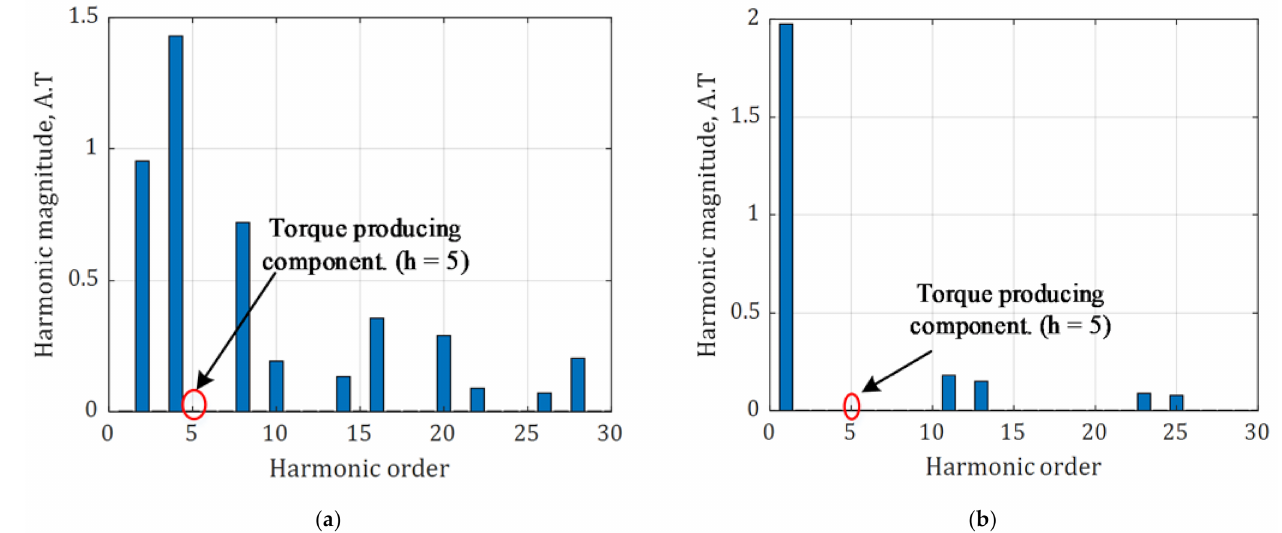
Figure 4. MMF harmonic spectra for six-phase 12-slot/10-pole SPM winding arrangements under charging mode: ( a ) Dual three-phase and ( b ) asymmetrical